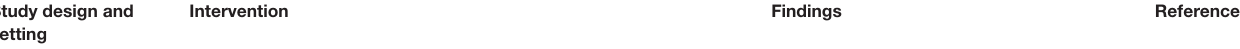
TABLE 1 | Intervention studies and programs applying choice architecture modifications to encourage healthier food choices in food pantry and retail settings for low-income populations. Study design and